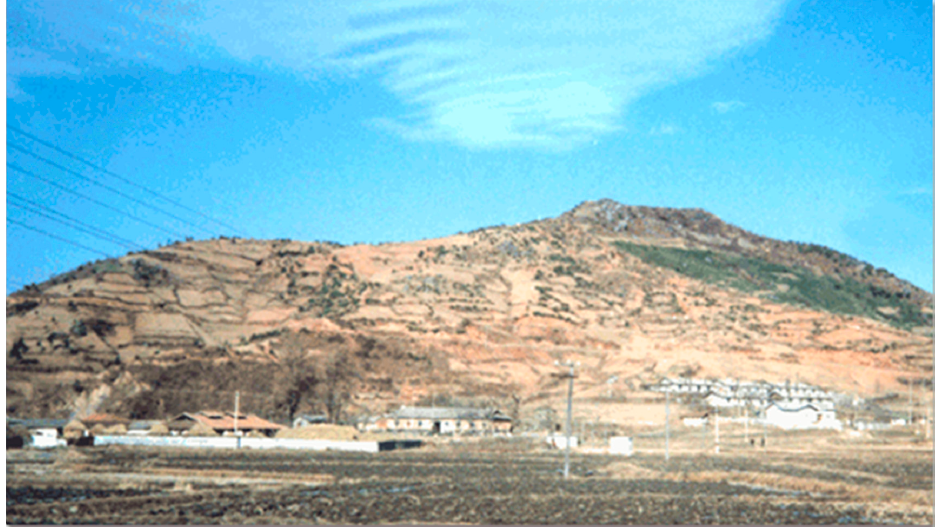
Figure 7. Terraced crop fields in North Korea (Source: http://www.forest.go.kr/newkfsweb/html/HtmlPage.do?pg=/partic/partic_1104_con02.html&mn=KFS_02_08_06_03_04).